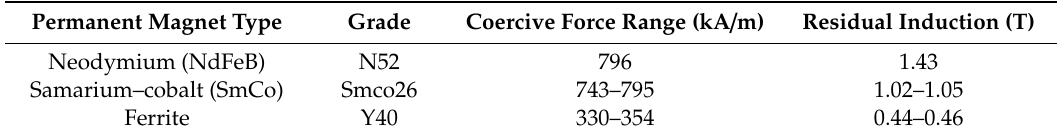
Table 3. Properties of various permanent magnets